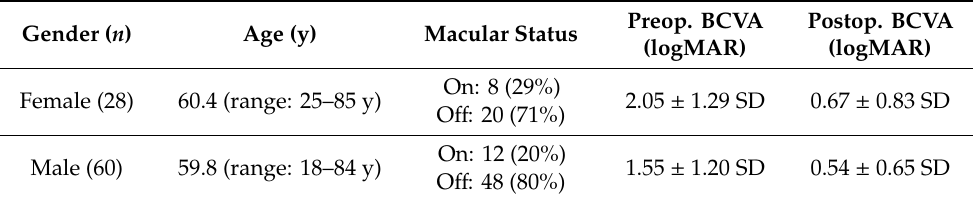
Table 1. Patients’ characteristics.